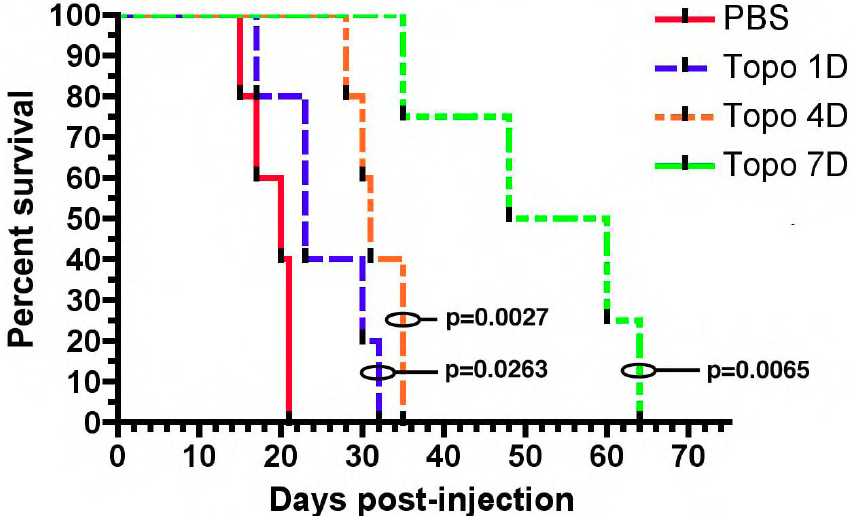
Figure 1. Chronic convection enhanced delivery (CED) of topotecan provides a significant survival advantage. Rats with orthotopic virally-induced, platelet derived growth factor (PDGF) driven tumors were treated with CED of topotecan for various days (1, 4, or 7 days). p -values show a comparison to the PBS control. 1, 4, and 7 days CED survival were each significantly greater than PBS ( p < 0.05). The median survival for 7 days CED was significantly greater than the other groups, (median survival: PBS—20 dpi, 1 day—23 dpi, 4 day—31 dpi, 7 day—54 dpi; p < 0.05). The figure